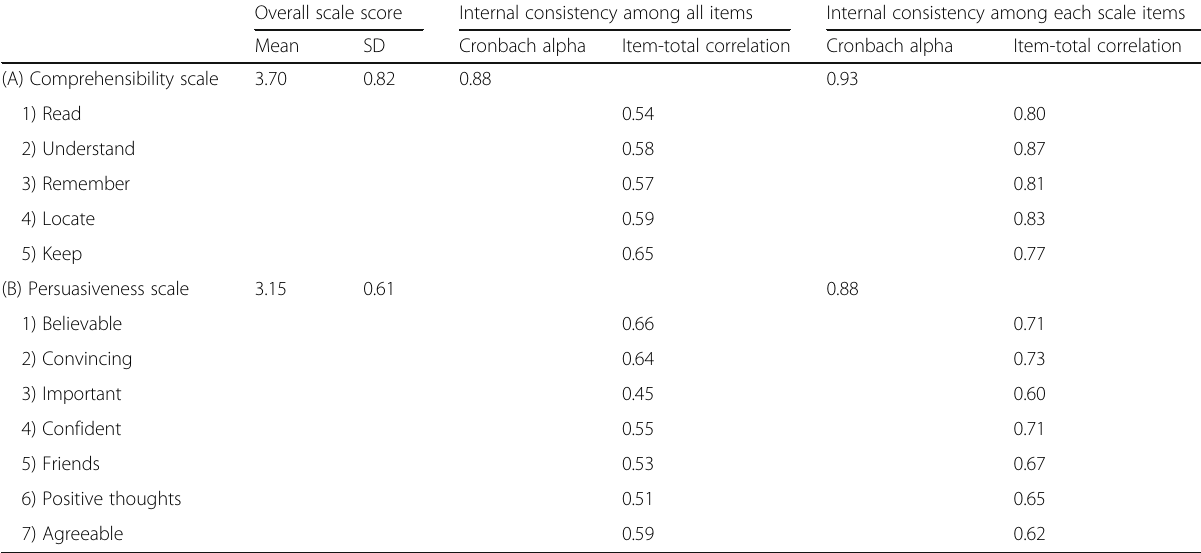
Table 3 Internal consistency of the comprehensibility and persuasiveness scales Overall scale score Internal consistency among all items